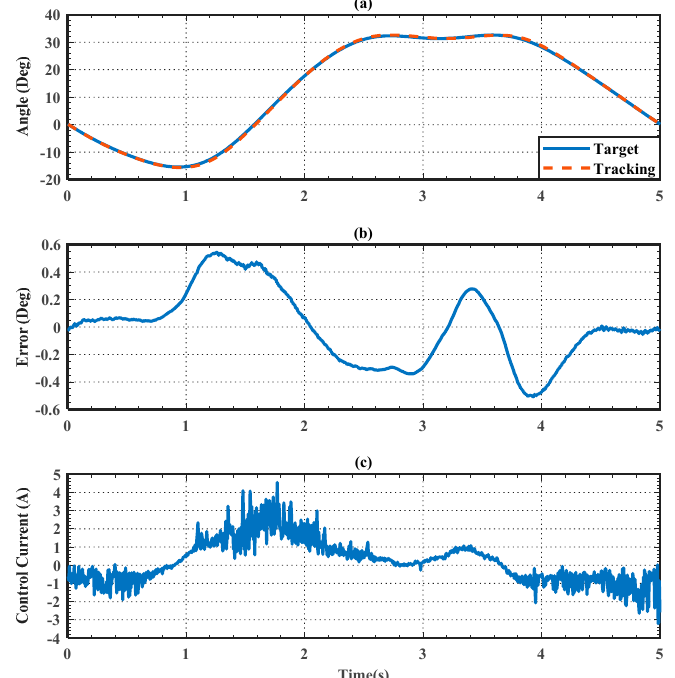
Figure 15. Right hip joint trajectory tracking for LES during the overground gait training with the ILESO − PSMC. ( a ) Hip joint angle tracking response; ( b ) hip joint angle tracking error; ( c ) current control signal.